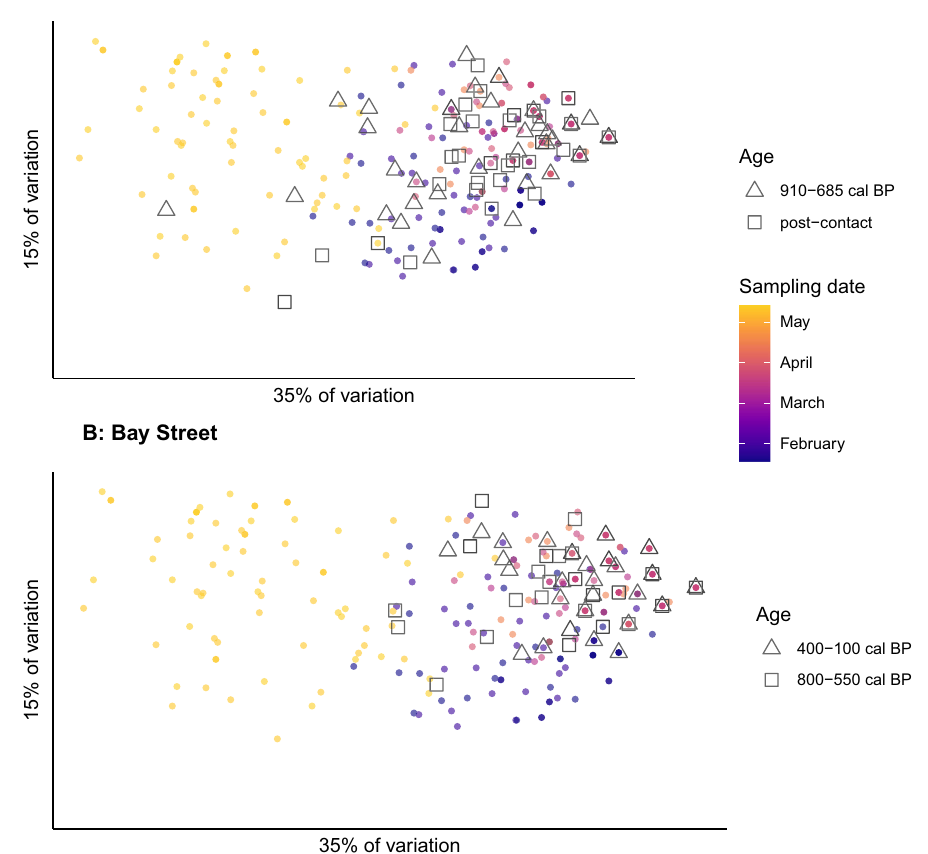
Figure 2. Principal Component Analyses of modern and ancient herring samples based on genetic variability at seven SNP loci. Modern samples are represented as points whose color indicates the date of sample collection (as in Supplemental Fig. 1). The ancient herring samples are represented by black triangles or squares, depending on their estimated age. ( A ) Comparison of archaeological herring from the Burton Acres Shell Midden to modern herring; ( B ) Comparison of archaeological herring from the Bay Street Shell Midden to modern